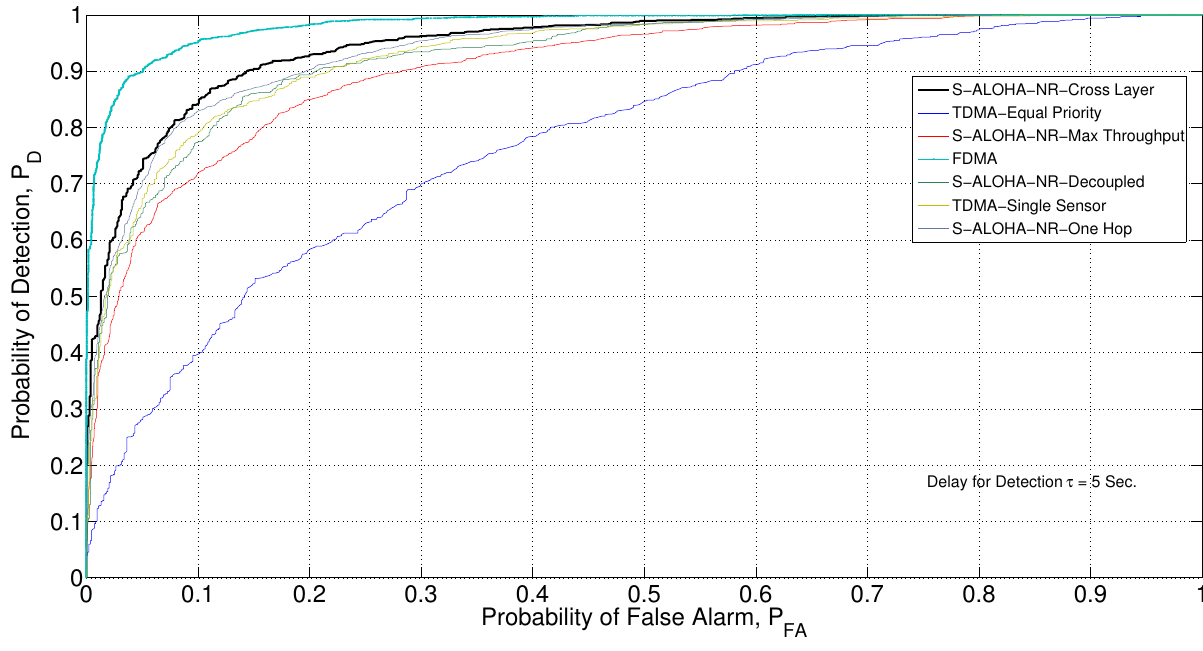
Figure 14. ROC curve for various network designs, Monte Carlo simulation (MCS)